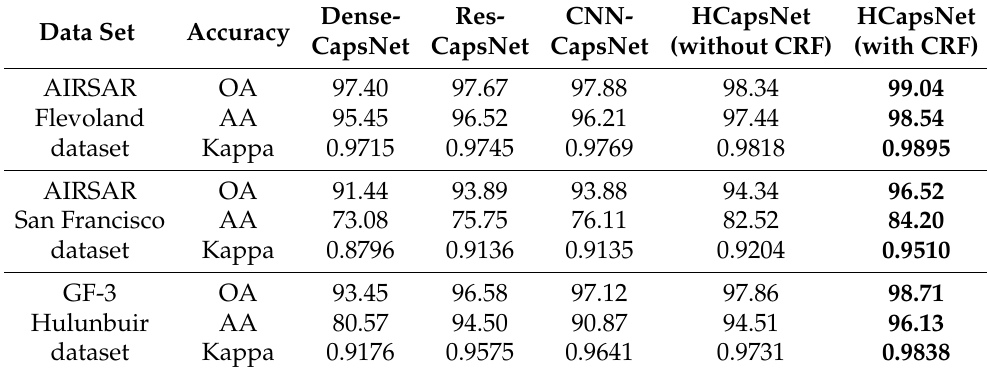
Table 12. Comparison of the classification accuracy with different methods.